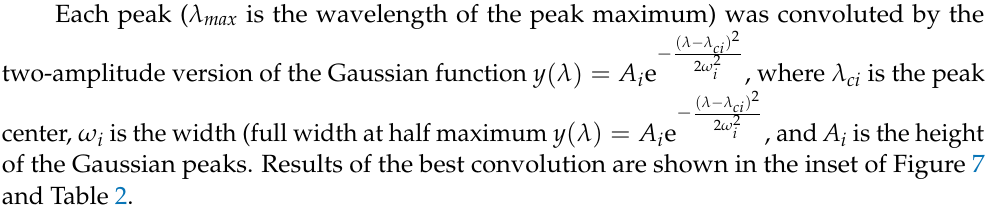
Table 2. Results of PL analysis.